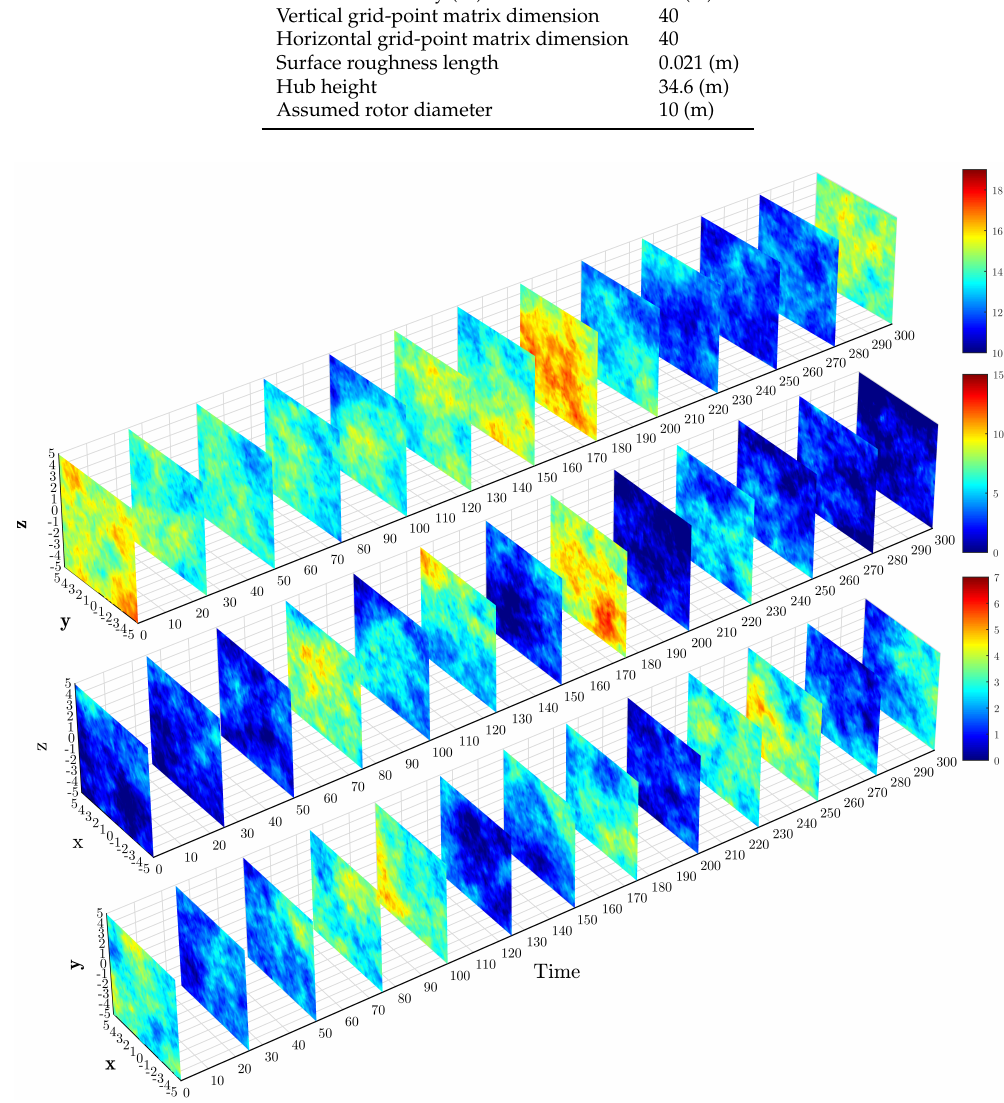
Figure 9. Turbulent wind field simulation in streamwise ( top ), crosswise ( middle ), and vertical direction ( bottom